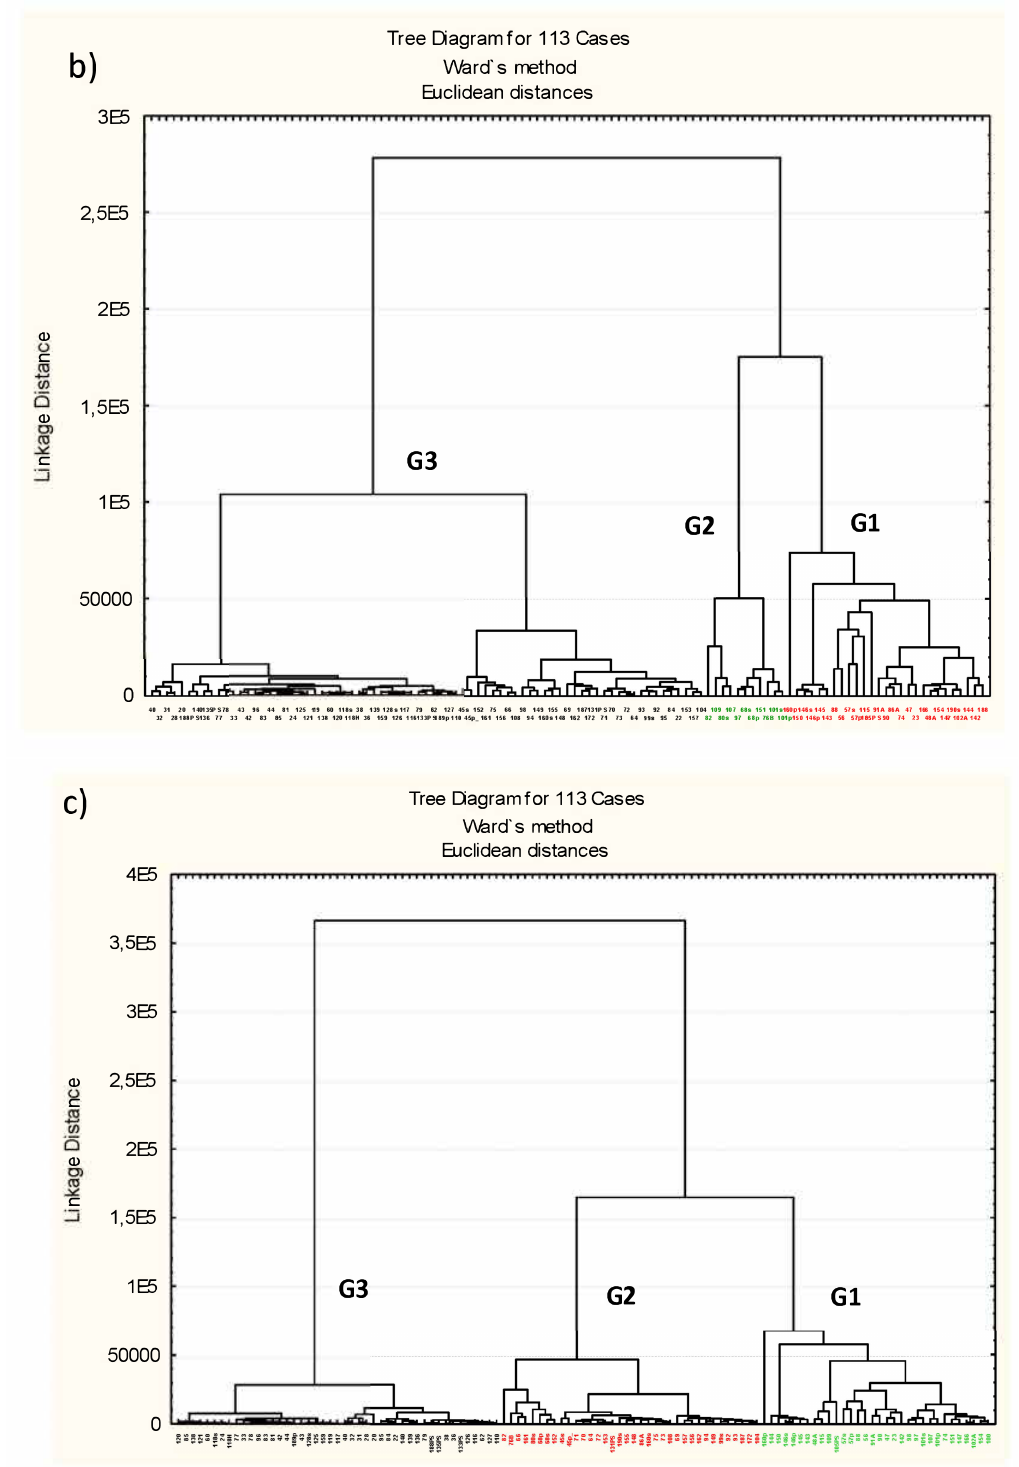
Figure 2. Cluster analysis of anisakids samples L3 considering three different taxonomic levels of bacteria; phyla ( a ), order ( b ) and genus ( c ). Substantially the same structure is maintained from phyla to order level. At genus level a new significant cluster (green) is formed joining samples from red and green clusters from higher taxonomic levels, while the extended black cluster from phyla and order levels is split in two (black and red). This structure is manifested by ordination methods through correspondence and detected by the factorial analysis (Figures